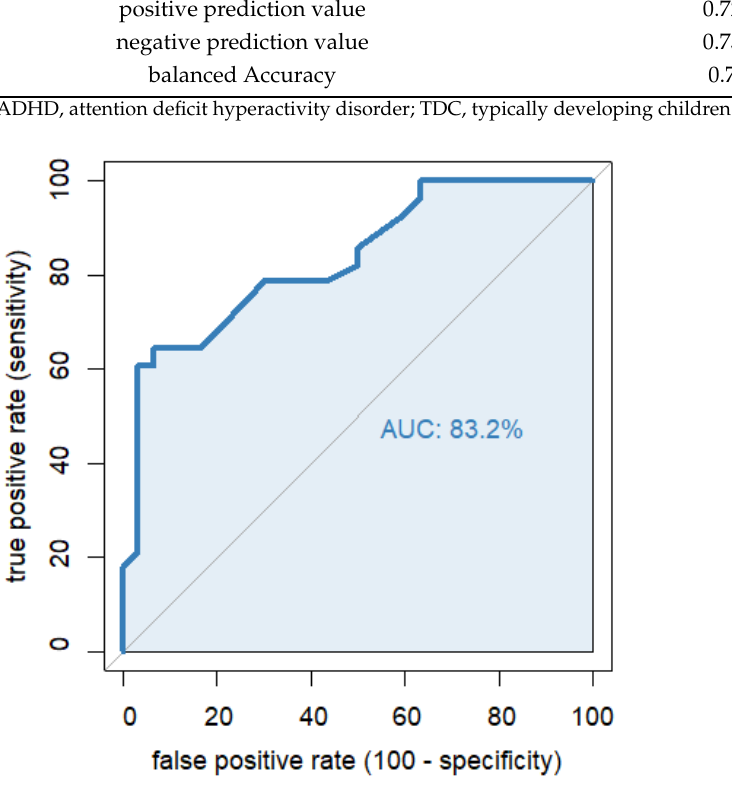
Figure 2. Receiver operating characteristic (ROC) curve for odor.